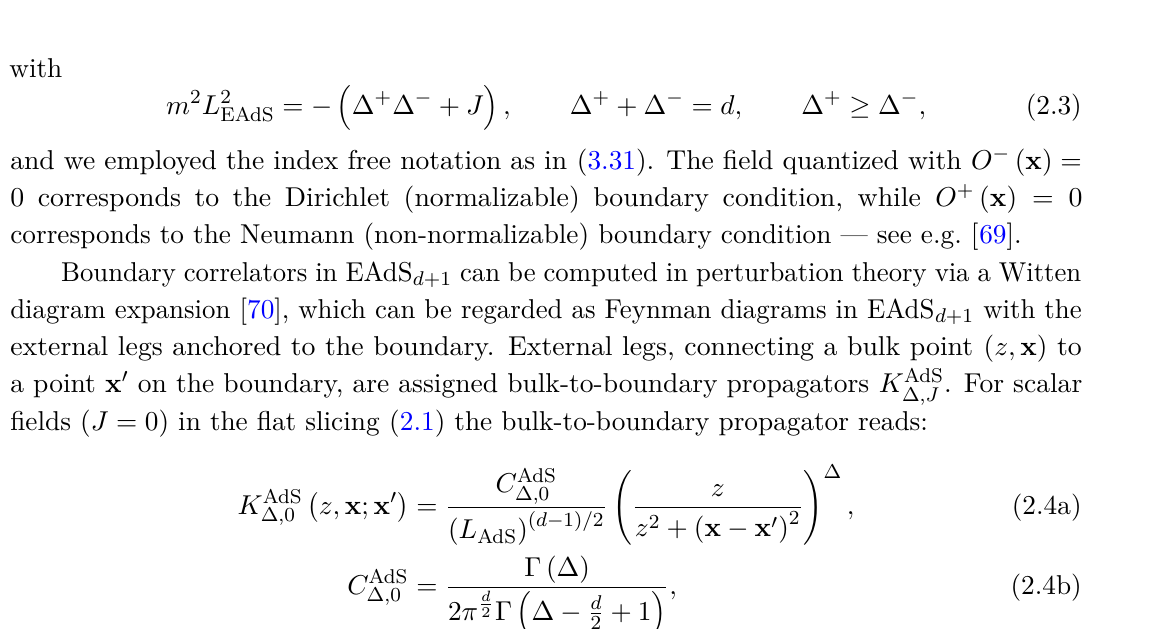
Figure 1. Throughout we represent EAdS pictorially as a Poincaré disk with grey circular boundary. Left: bulk-to-boundary propagator in EAdS with boundary condition ∆ , where ∆ = ∆ ± . Right: bulk-to-bulk propagator in EAdS with ∆ ± boundary